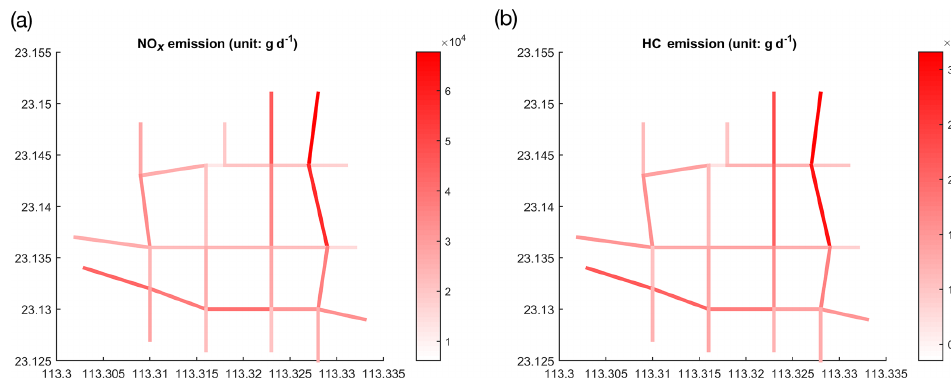
Figure 11. The spatial distribution of weekday (a) NO x and (b) HC emissions in the simulated street network.